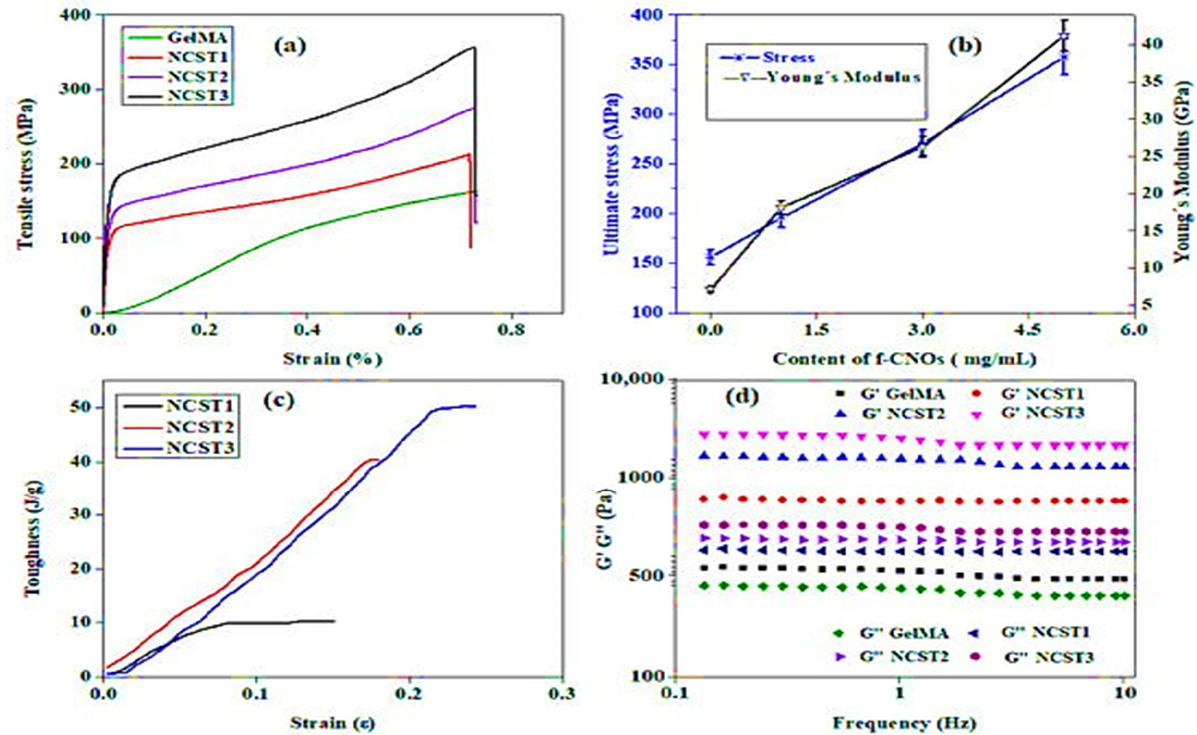
Figure 9. Graphs demonstrating hydrogel physicomechanical characteristics: ( a ) tensile stress; ( b ) tensile strain versus elastic moduli; ( c ) impact strength; and ( d ) storage and loss modulus (G ′ G ″ ). Reproduced with permission from [301].